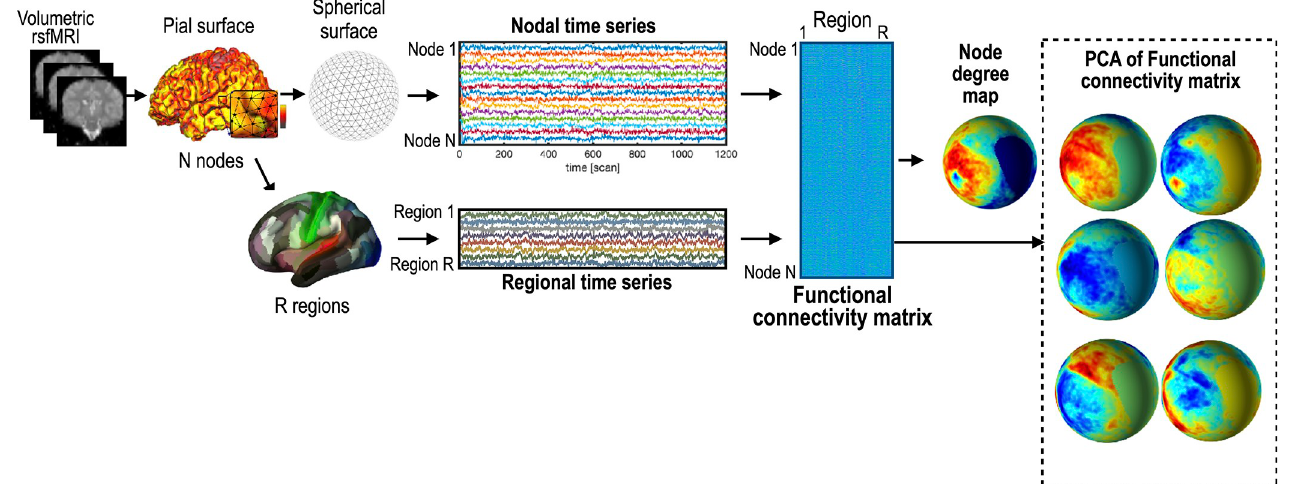
Fig 1. Procedure to extract surface-based resting-state functional connectivity properties. A N nodes x R regions connectivity matrix was constructed by calculating Pearson’s correlation coefficient from all the nodes in the sphere and all the regions in the parcellation map. From the connectivity matrix, functional connectivity features were